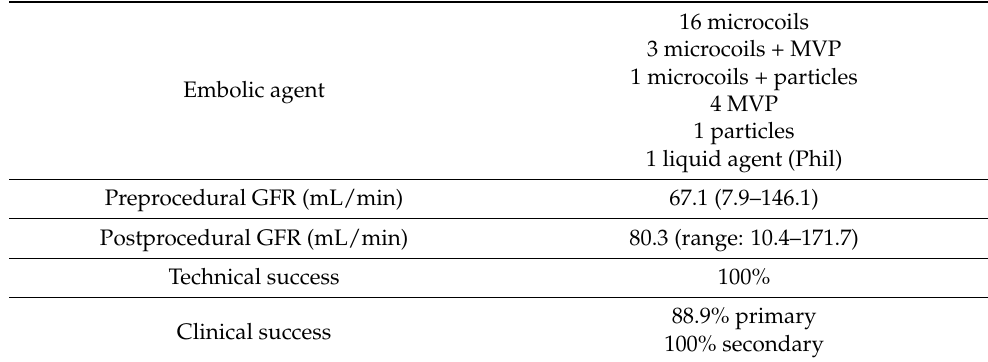
Table 3. Embolization